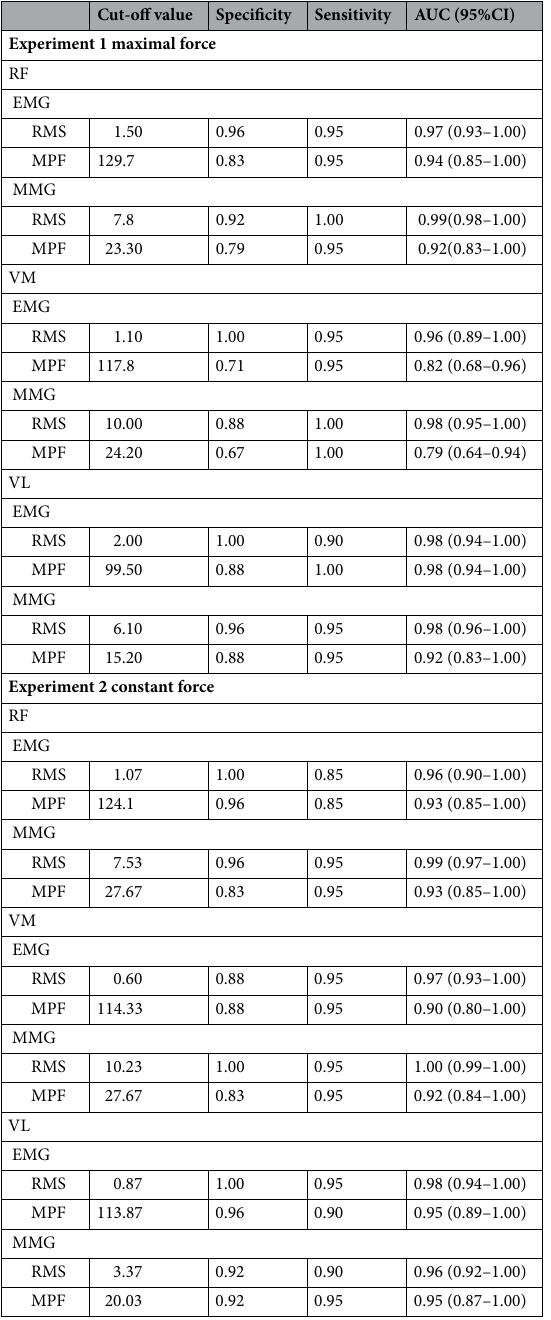
Table 3. Diagnostic parameters of the ROC curve for each parameter. Data of cut-off value are shown as mV for EMGRMS, µm for MMGRMS, and Hz for EMGMPF and MMGMPF. ROC receiver operating characteristic, AUC area under the curve, CI confidence interval, RF rectus femoris, VM vastus medialis, VL vastus lateralis, EMG electromyography, MMG mechanomyography, RMS root mean square, MPF mean power